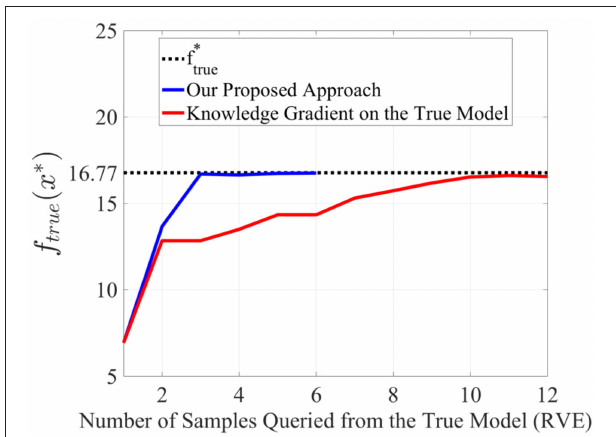
FIGURE 8 | The optimal solution obtained by our proposed approach and by applying the knowledge gradient on a GP of only the true data (RVE) for different number of samples queried from the true model. Image sourced from Ghoreishi et al. (2018); use permitted under the Creative Commons Attribution License